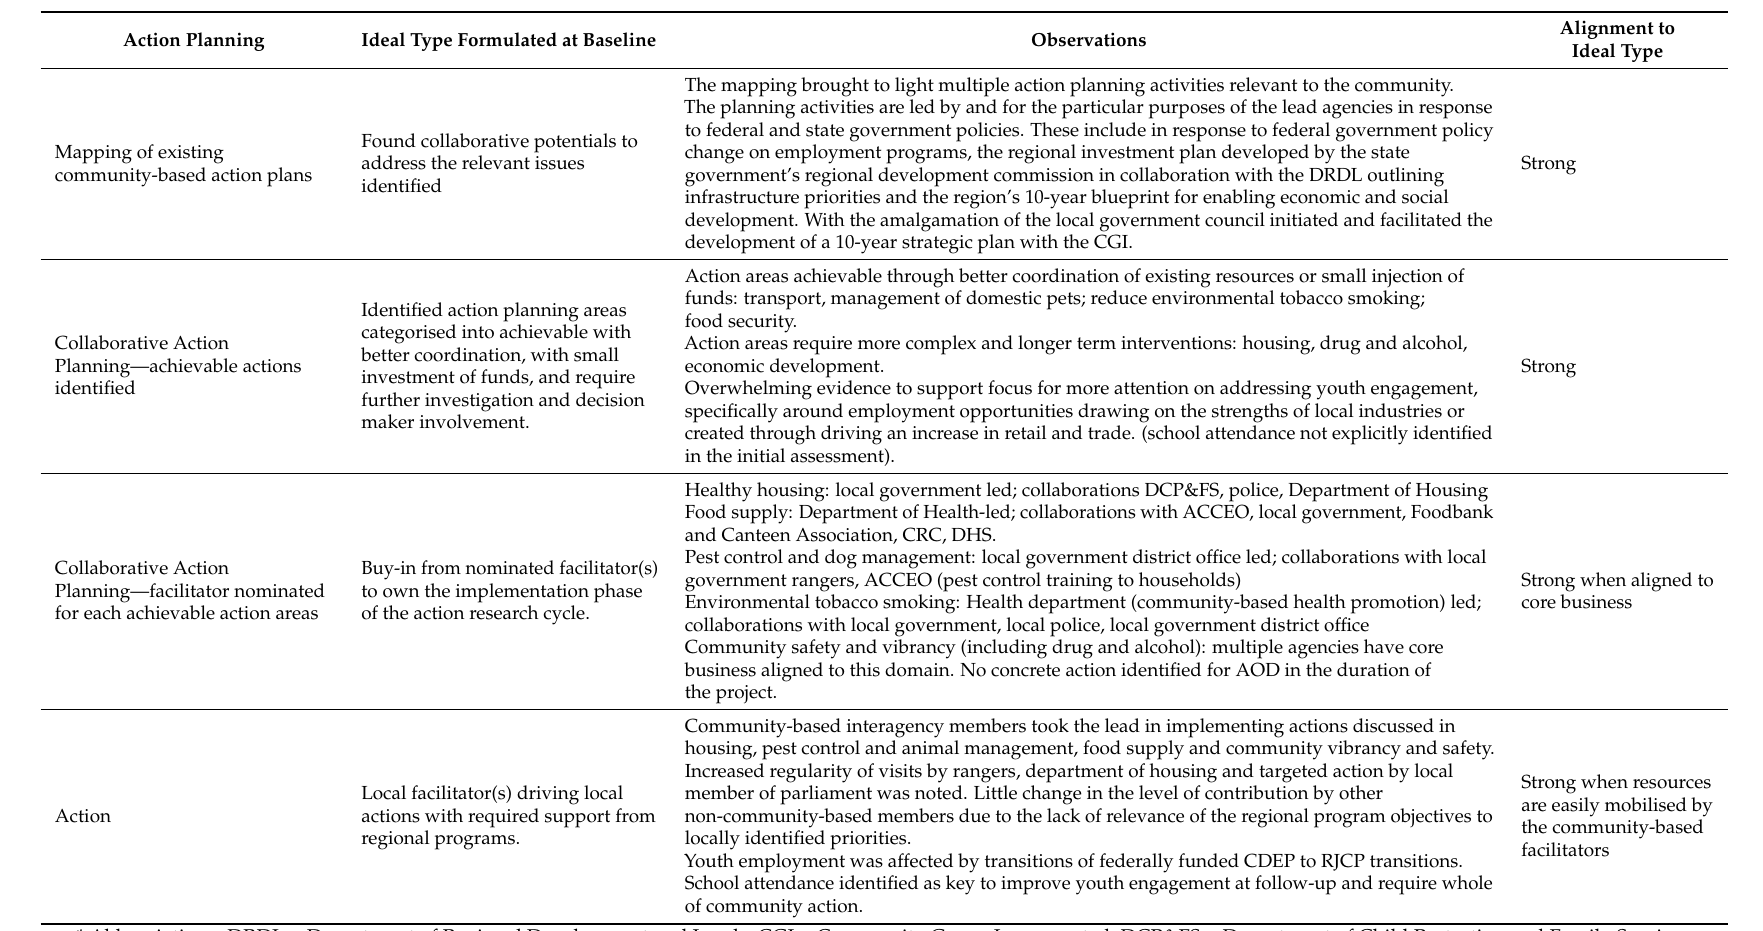
Table 2. Alignment of the Community’s Interagency Action Planning Process to the Ideal Type Formulated at